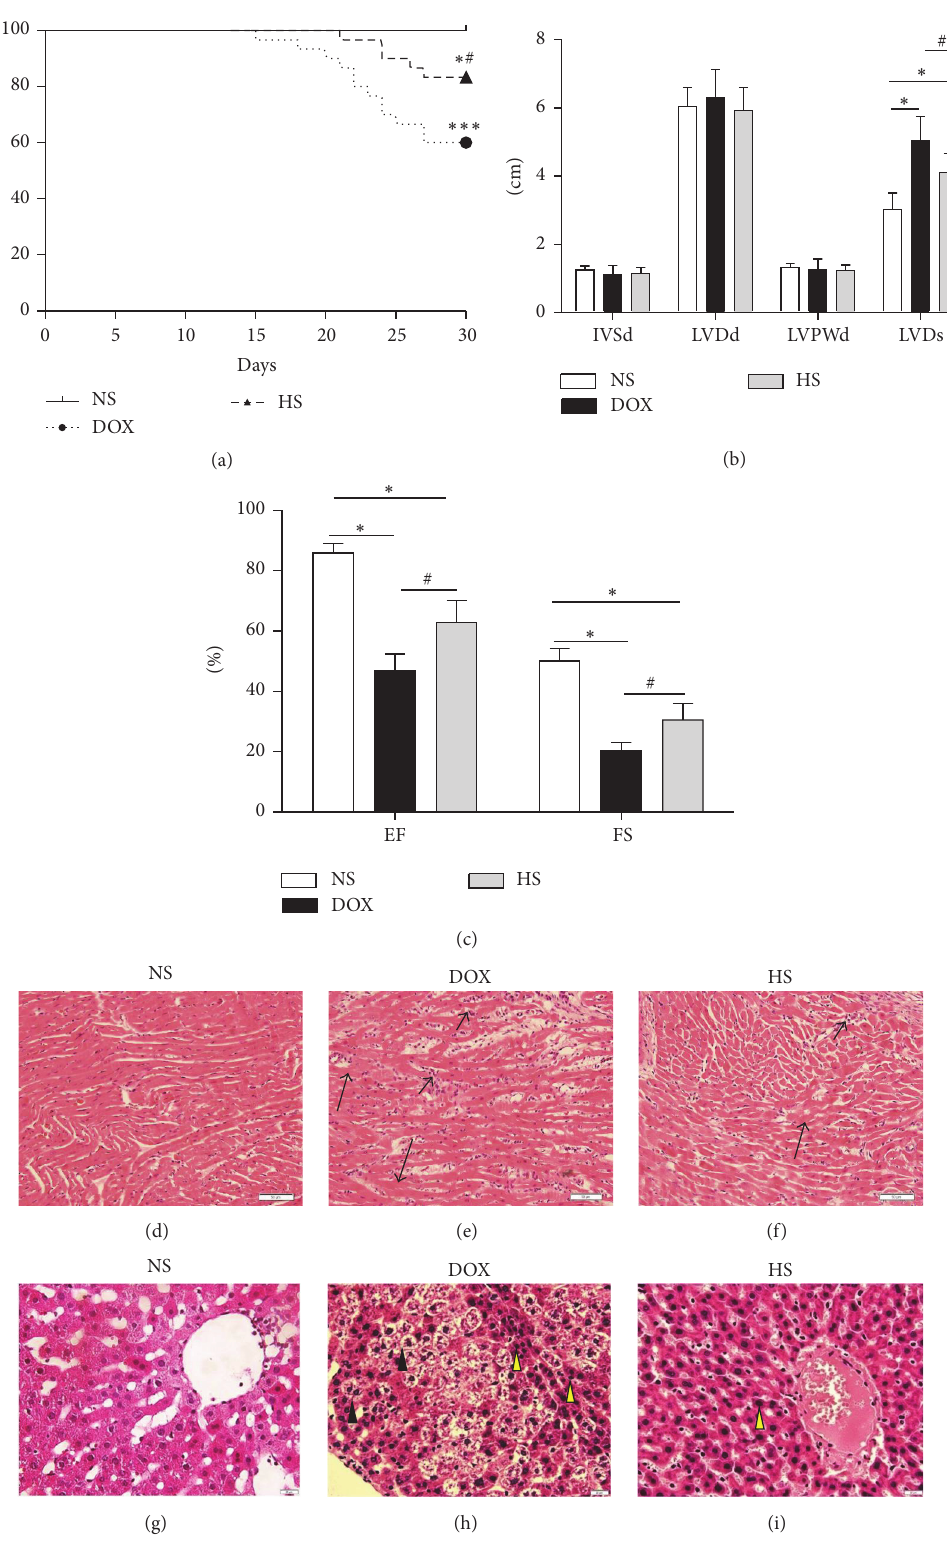
Figure 1: Effects of hydrogen-rich saline treatment on mortality, cardiac dysfunction, and pathological changes. Kaplan–Meier analyses of cumulative survival at 30 days after different treatments (a). The IVSd, LVDd, LVPWd, LVDs, EF, and FS of each rat were assessed ((b) and (c)). Morphologic changes of the heart (200x magnification; (d–f)) and liver (400x magnification; (g–i)) were processed for HE staining at 30 days (short arrows for infiltrated inflammatory cells and long arrows for focal myolysis; yellow arrowheads for karyopyknosis and black arrowheads for vacuolar degeneration). ∗ 𝑃 < 0.05 versus NS group; ∗∗∗ 𝑃 < 0.001 versus NS group; # 𝑃 < 0.05 versus DOX